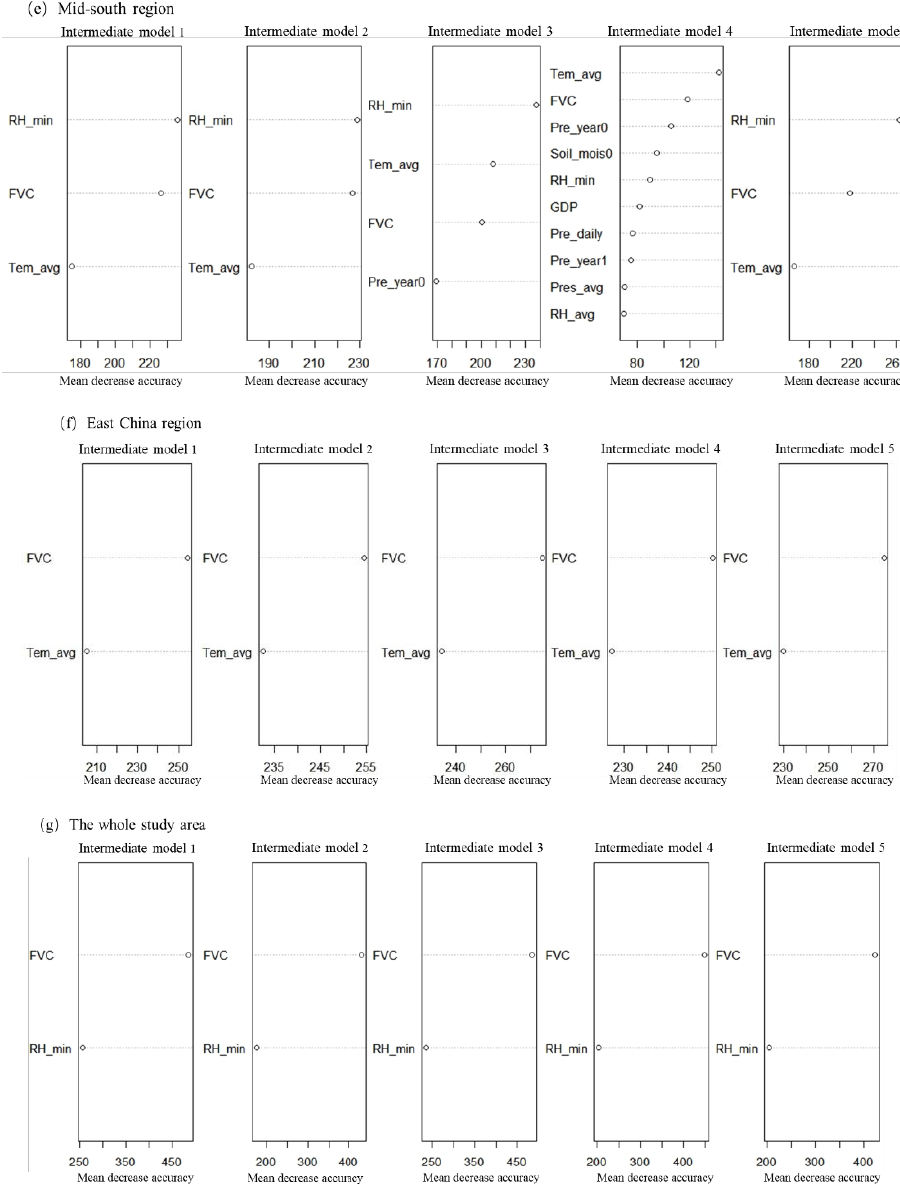
Figure A1. Importance rankings of the significant variables according to the mean decrease accuracy in each intermediate model in six geographical regions and the whole study area. The abbreviated variable names are the same as in Table A1.